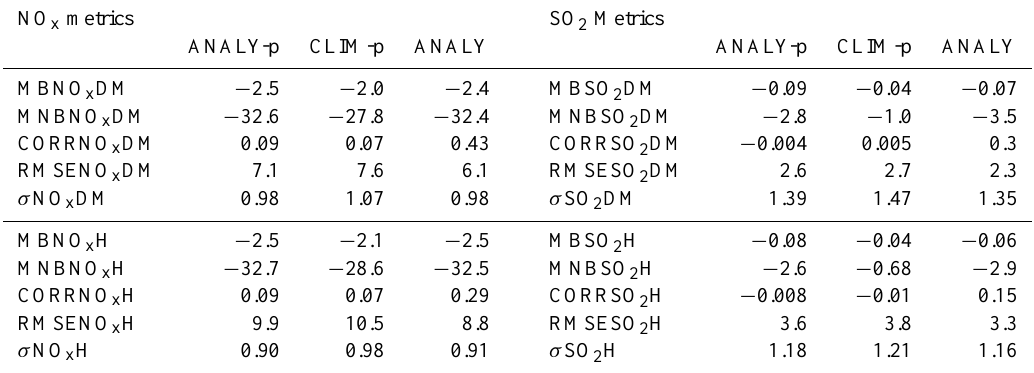
Table 11. Same as Table 10 for hourly values and daily average of NO x and SO 2 . NO x metrics SO 2 Metrics ANALY-p CLIM-p ANALY ANALY-p CLIM-p